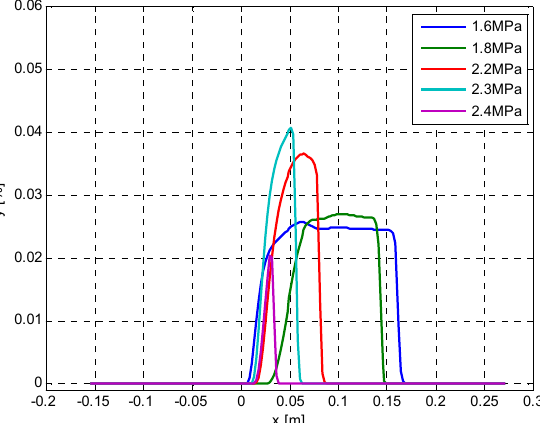
Figure 10. Humidity distribution curves along the axial cross-section of the supersonic separator.